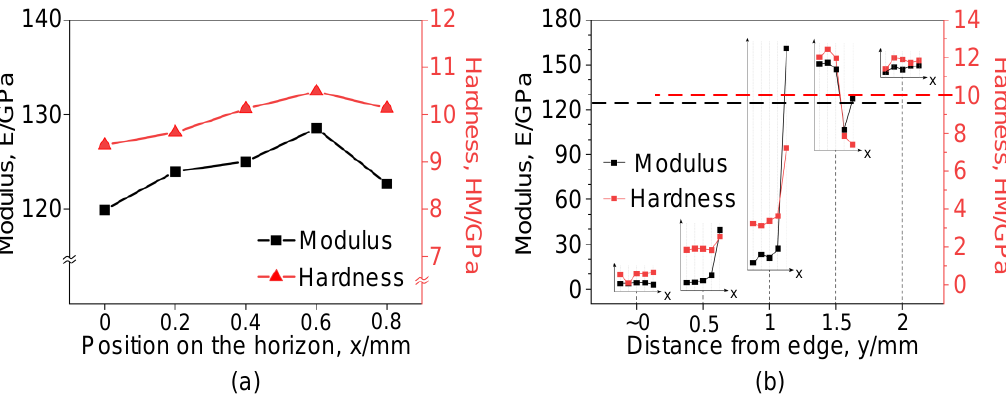
Figure 11. Nanoscale mechanical properties of samples at different positions, including elastic modulus and hardness, before and after W-EDM. ( a ) Nanoscale mechanical properties of the original ribbon, and ( b ) processed samples. The black dotted line represents the modulus of the original ribbon, and the red dotted line represents the hardness of the original